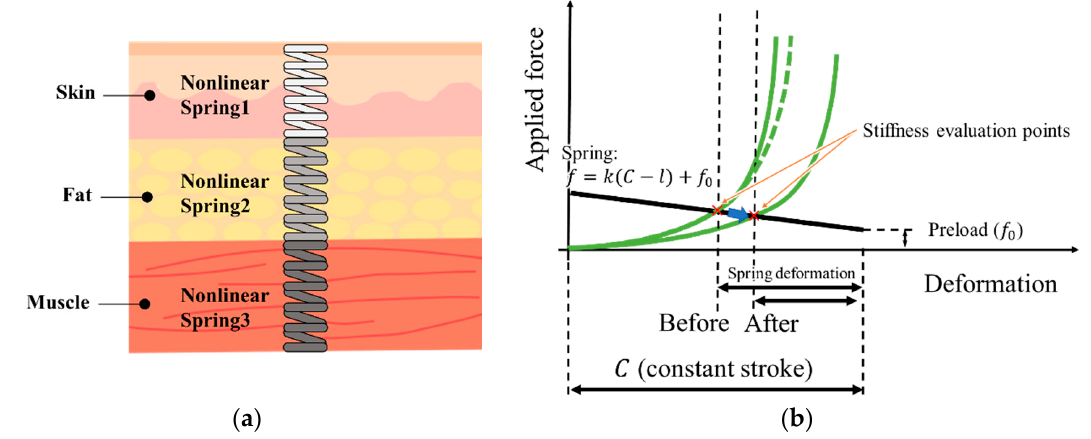
Figure 1. ( a ) Layers of abdomen. ( b ) Force–deformation curve for entire human abdominal wall with spring behavior indicating stiffness evaluation points.